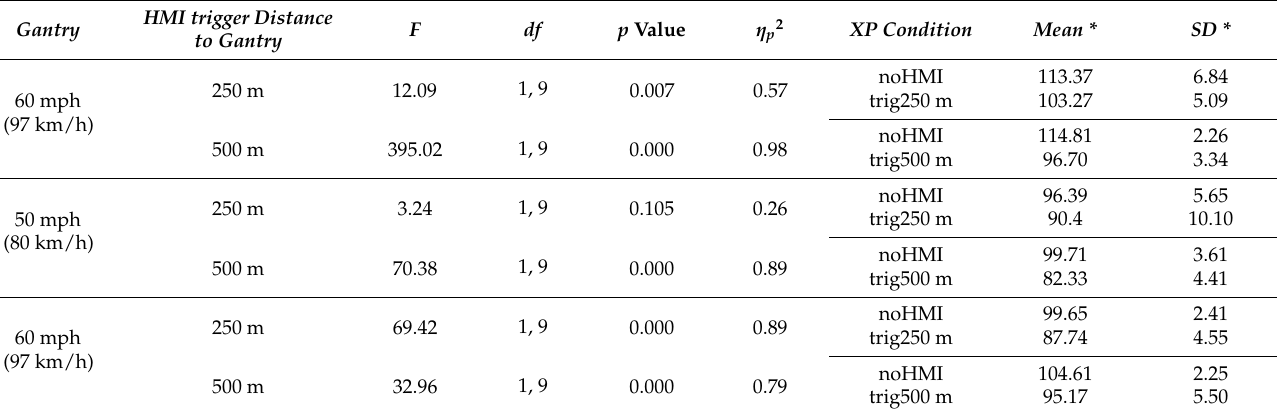
Table 9. Repeated measures ANOVA conducted to compare speed at gantry between the noHMI and the HMI conditions (i.e., trig250 m and trig500 m) for the same sequence of gantries.